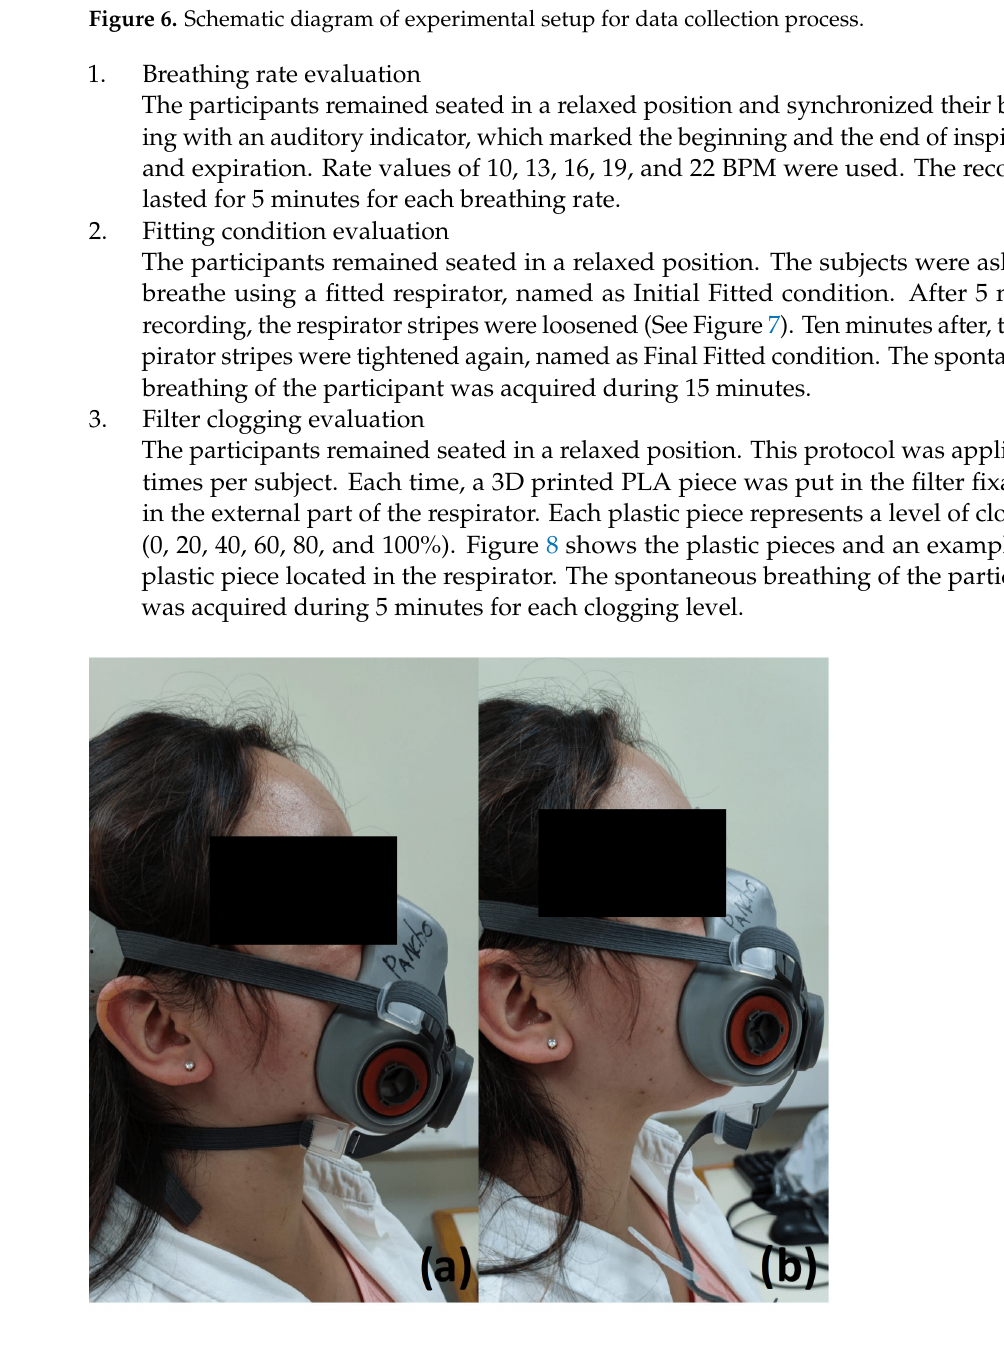
Figure 7. Volunteer with the reusable respirator in fitted ( a ) and loose ( b )